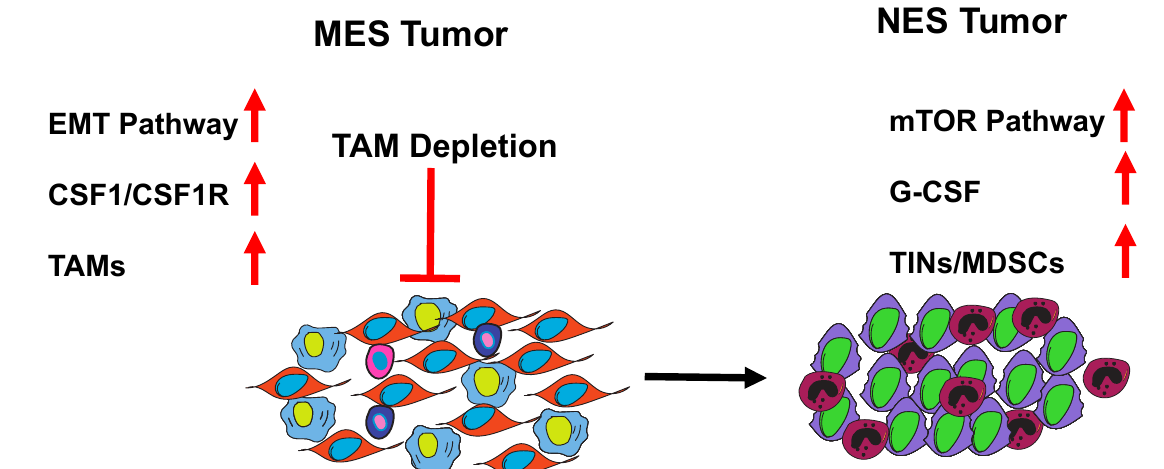
Figure 1. Macrophage (MES) tumors can switch to neutrophil (NES) tumors upon depletion of tumor-associated macrophages (TAMs). The depletion of TAMs in macrophage-enriched tumors by using CCR2-/- mice and a CSF1 neutralizing antibody alongside liposomal clodranate results in an interesting phenotypic switch in these tumors leading instead to the recruitment immunosuppressive neutrophils (Figure 1). Resistance to checkpoint blockade in these tumors is also mediated by the accumulation of neutrophils. Depleting these neutrophils by using a Ly6G neutralizing antibody in combination with checkpoint blockade led to a significant reduction in tumor recurrence